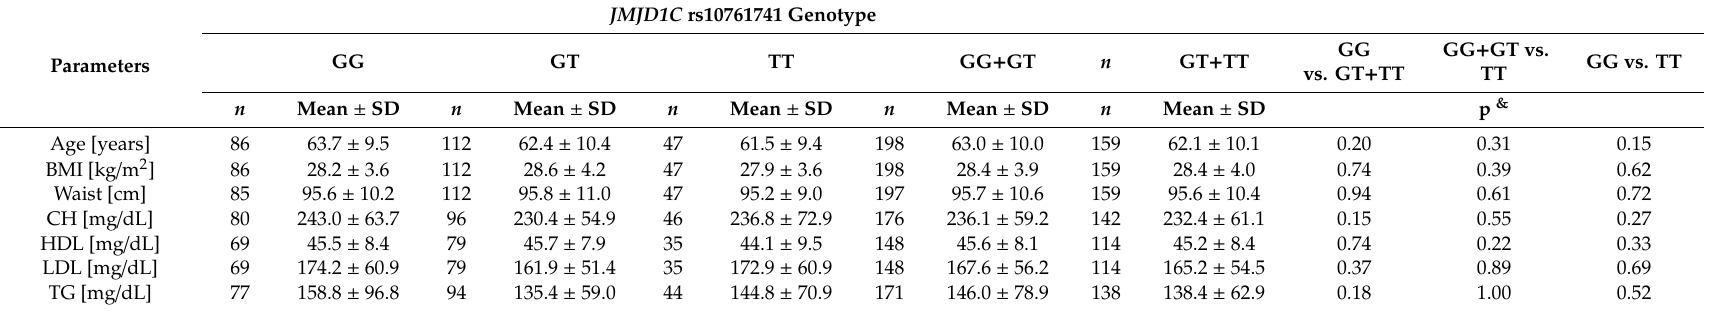
Table 7. Associations between the clinical parameters of patients with unstable angina and the JMJD1C rs10761741